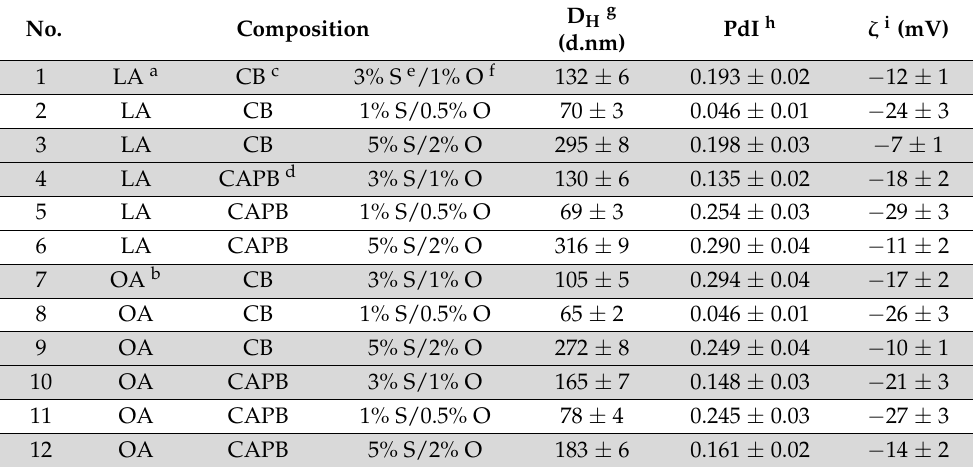
Table 1. Sample results from DLS and ELS for the obtained